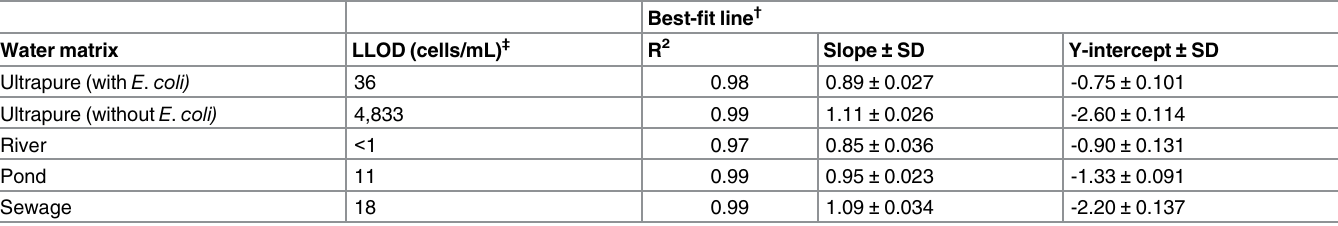
* In three different experiments, water samples were spiked with 1 × 10 6 Leptospira /mL and 10-fold serially diluted down to 1 × 10° Leptospira /mL † Calculated from linear regression of data obtained from 3 independent experiments. ‡ As determined by Probit regression